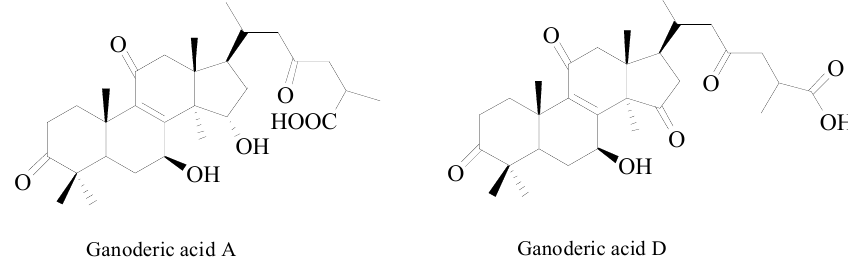
Figure 11. Chemical structures of Ganoderic acid A and D.